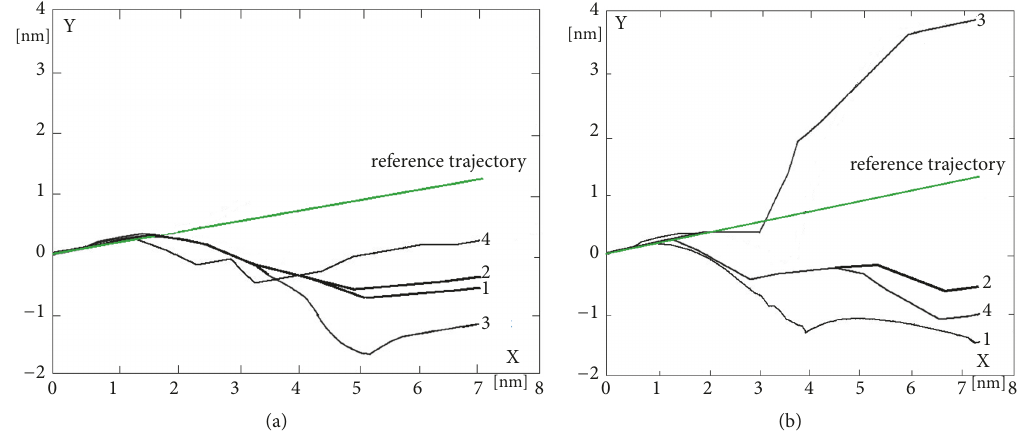
Figure 8: Comparison of safe trajectories of own ship in the situation of passing by with 𝐽 = 34 met ships, determined by individual four algorithms: (1) positional noncooperative game, (2) positional cooperative game, (3) matrix noncooperative game, and (4) matrix cooperative game; (a) conditions of good visibility at sea for 𝐷 𝑠 = 0.3 nm and (b) conditions of restricted visibility at sea for 𝐷 𝑠 = 1.5